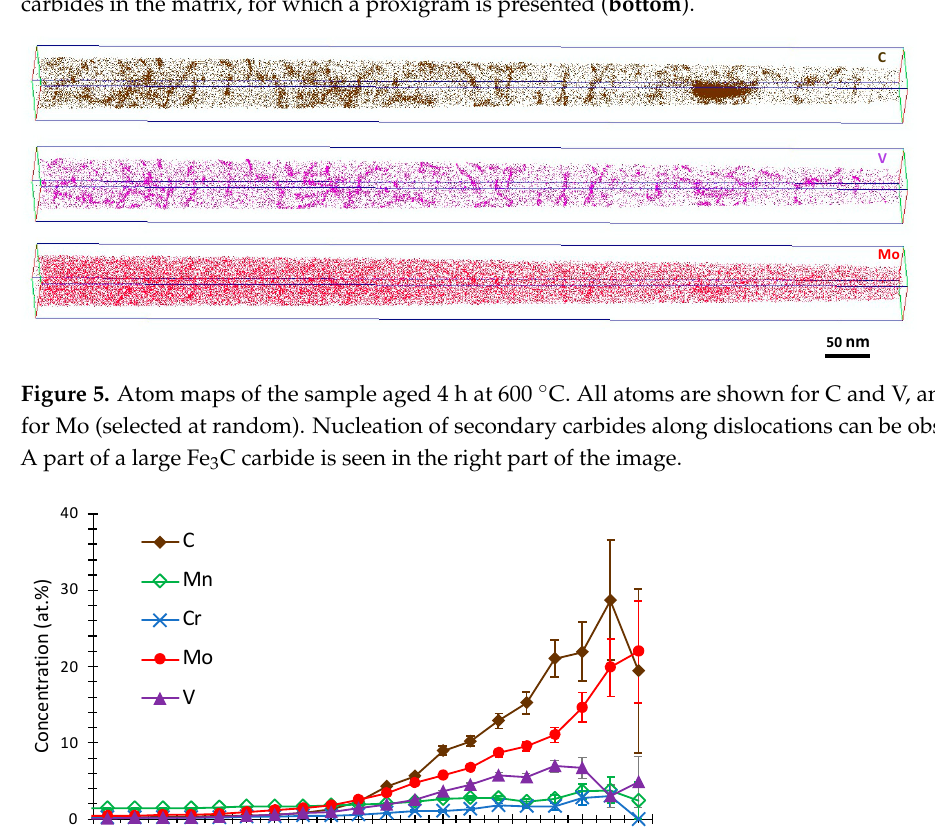
Figure 5. Atom maps of the sample aged 4 h at 600 °C. All atoms are shown for C and V, and 30% for Mo (selected at random). Nucleation of secondary carbides along dislocations can be observed. A part of a large Fe 3 C carbide is seen in the right part of the image. Figure 7. A 0.6 nm thick slice, from the sample aged 4 h at 600 °C. ( a ) All detected ions of Fe (grey). ( b ) All detected ions of Fe (grey), Mo (red), V (turquoise), and C (black) are shown. To increase visibility, the atoms of Mo, V, and C are drawn larger than the Fe atoms. For the samples aged for 8 h, 40 h, and four weeks at 600 °C, carbon atom maps are presented in Figure 8. There were still carbides present along dislocations after 8 h, but were much shorter and thinner compared to the 4 h sample, but after the two longer pe ‐ riods, there were no signs of carbides at dislocations. The very few carbides observed after 40 h and four weeks were round and rich in V and Mo, and they were present at lath boundaries, and not any longer at dislocations. In the analysis of the sample aged for four weeks, the analyzed volume contained a lath boundary with two MC carbides that con ‐ tained slightly more Mo (27 at%) than V (21 at%). In this case, the measured C concentra ‐ tion was close to 50 at%, supporting the assumption that they were indeed MC. There was also surely some cementite present, but no such carbides were observed in the investi ‐ gated volumes. In the analysis of the material aged for 8 h, two large Fe ‐ carbides (presum ‐ ably Fe 3 C, see Figure 8) with enrichments of Mn, Cr, Mo, and V were observed. Figure 9 shows a proxigram, constructed using isosurfaces of C + Mo + V = 3 at%, from all the small carbides, all containing Mo and V, in the sample aged for 8 h. Some of these carbides were located on dislocations, but some might not necessarily have been located on dislocations. These carbides were smaller than in the 4 h sample, suggesting that they were dissolving, providing C, V, and Mo to larger carbides that were growing (i.e., coarsening was taking place). The composition of the small carbides was similar to the composition after 4 h, as can be seen when comparing the proxigrams in Figures 6 and